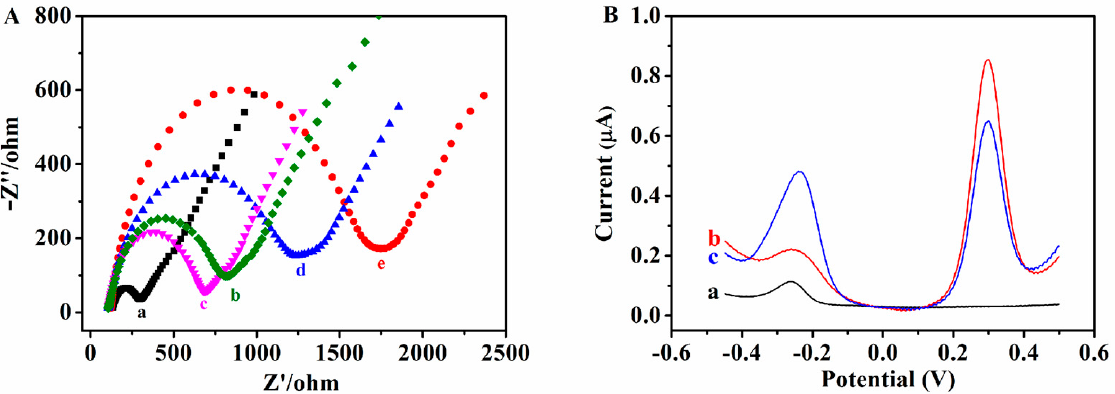
Figure Figure 4. ( A ) EIS spectra of (a) the bare GCE, (b) BPNS/GCE, (c) AuNPs–BPNS/GCE, (d) aptamer/AuNPs–BPNS/GCE and (e) cDNA/aptamer/AuNPs–BPNS/GCE in a mixture solution of 5.0 mM Fe(CN) 63 − /4 − containing 0.1 M KCl. ( B ) SWV measurements of cDNA/aptamer/AuNPs– BPNS/GCE in PBS (a) without FMCA, (b) with FMCA and (c) after incubation with PAT.